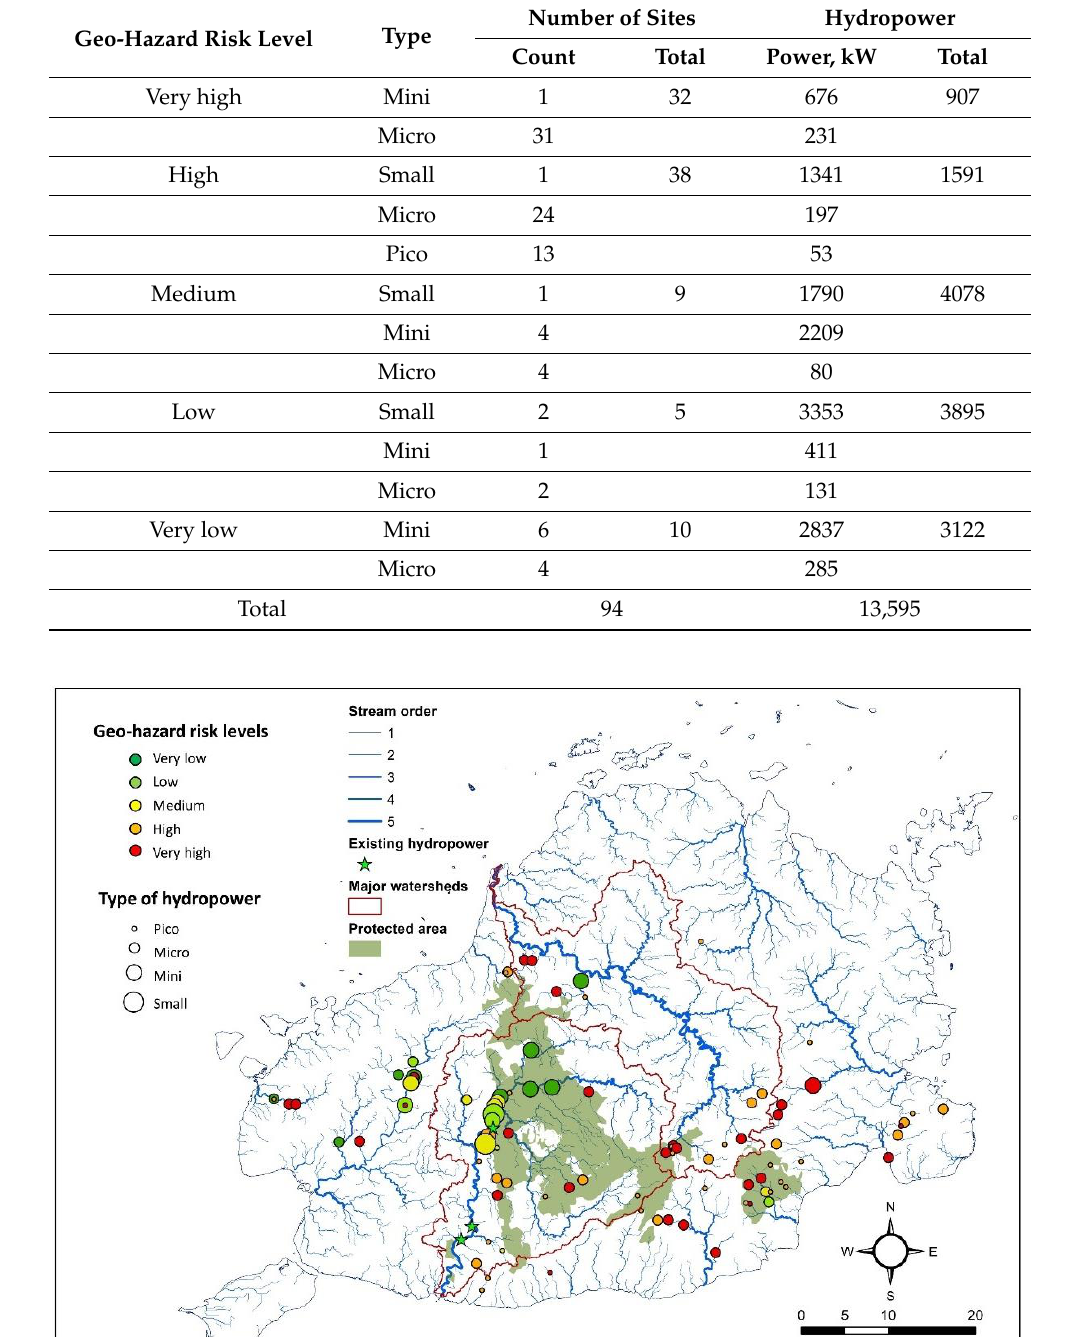
Table 6. Geo-hazard risk levels associated with the small-scale hydropower type and the power potential.